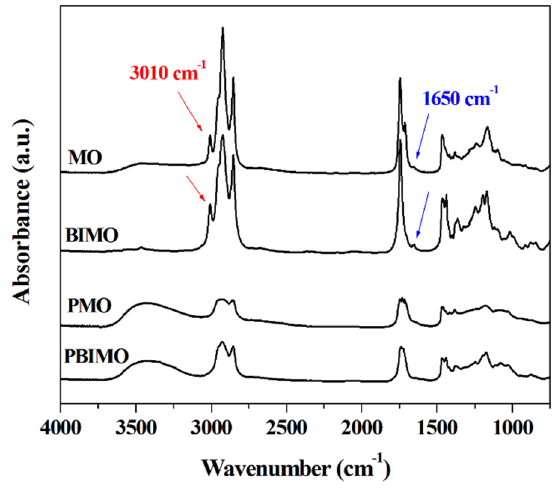
Figure 1. FTIR spectra of macauba oil (MO), polyol from macauba oil (PMO), macauba oil methyl esters (BIMO), and polyol from macauba oil methyl esters